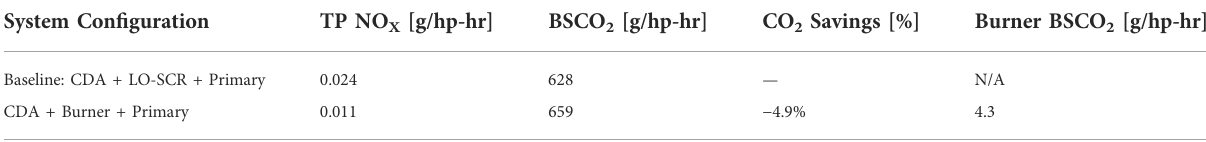
TABLE 9 LLC results comparison between Baseline and CDA + Burner + Primary